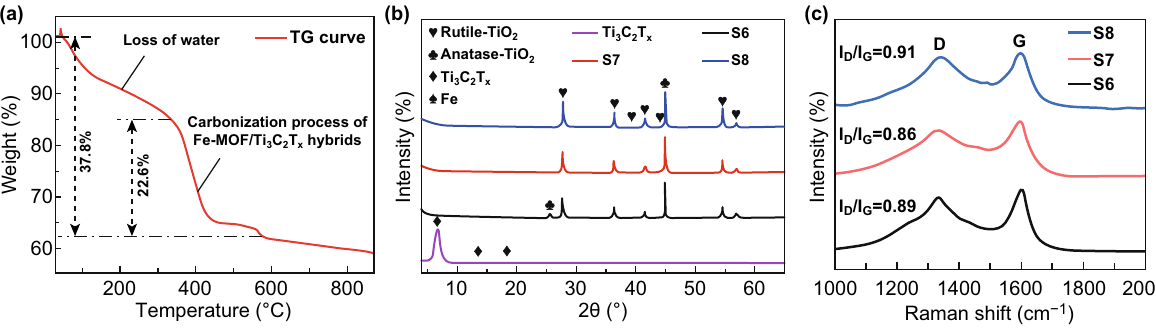
Fig. 2 a TG curve of as‑prepared Ti 3 C 2 T x –Fe‑MOF hybrids. b XRD patterns of as‑prepared Ti 3 C 2 T x , S6, S7, and S8. c Raman spectra results of S6, S7, and